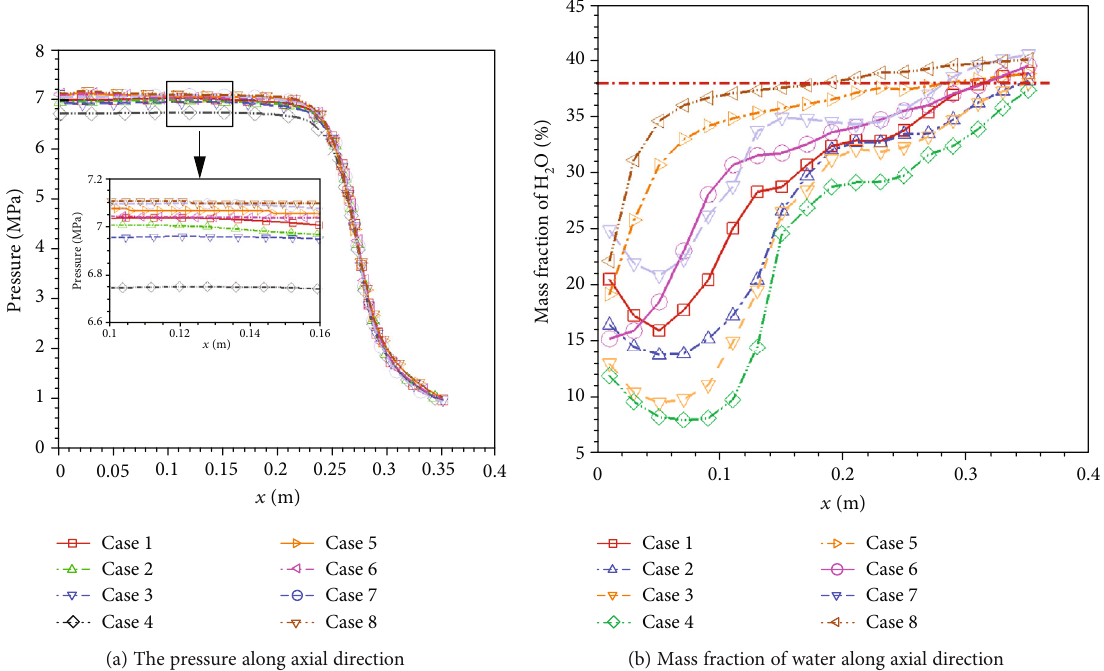
Figure 5: The numerical results of combustion e ffi ciency